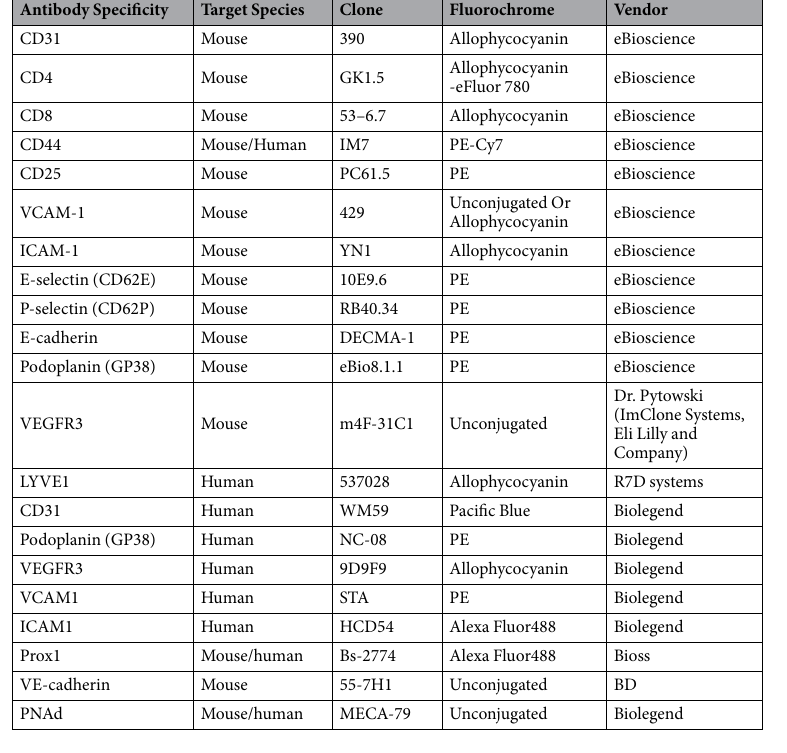
Table 1. Antibodies for flow